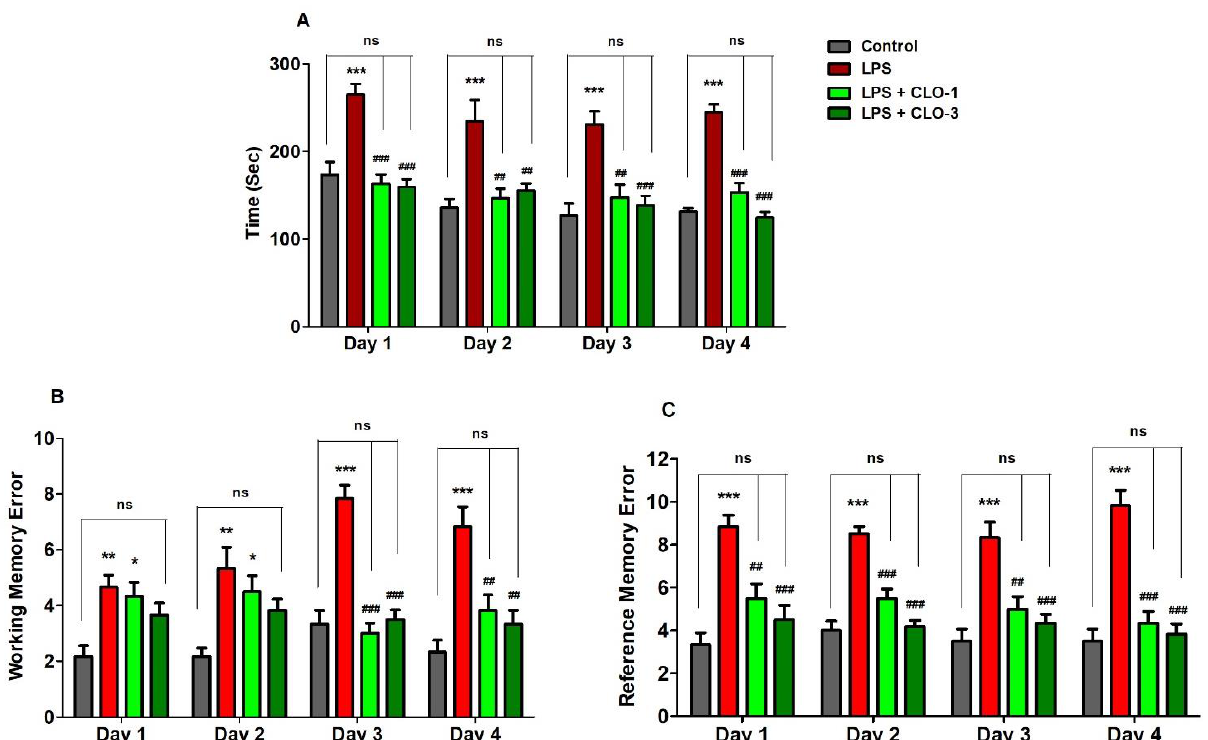
Figure 2. Effect of the clobenpropit (CLO) on the ( A ) time taken to consume all five baits (TTB), ( B ) working memory error (WME), and ( C ) reference memory error (RME) on day 1 to day 4 of memory assessment in lipopolysaccharide (LPS)-induced mice using radial arm maze. LPS-CLO-1 and LPS-CLO-3 refer to administration of clobenpropit (1 or 3 mg/kg, p.o., respectively) and lipopolysaccharides (250 µ g/kg, i.p.). TTB, WME and REM were increased by LPS-induced neuroinflammation. However, CLO treatment significantly reduced the LPS-induced TTB, WME and REM increments. The results are expressed as mean ± SEM ( n = 6). One-way ANOVA (TTB; F (3,20) = 17.87, p < 0.001 for day 1; F (3,20) = 9.030, p < 0.001 for day 2; F (3,20) = 11.74, p < 0.001 for day 3; and F (3,20) = 25.95, p < 0.001 for day 4), (WME; F (3,20) = 6.460, p < 0.01 for day 1; F (3,20) = 6.272, p < 0.01 for day 2; F (3,20) = 28.97, p < 0.001 for day 3; and F (3,20) = 12.39, p < 0.001 for day 4) (REM; F (3,20) = 14.88, p < 0.001 for day 1; F (3,20) = 29.21, p < 0.001 for day 2; F (3,20) = 13.41, p < 0.001 for day 3; and F (3,20) = 26.52, p < 0.001 for day 4) was followed by Tukey – Kramer multiple comparisons tests.* p < 0.05, ** p < 0.01, and *** p < 0.001 as compared to the control group; ns, not significant as compared to the control group; ## p < 0.01 and ### p < 0.001 as compared to the LPS-treated group.